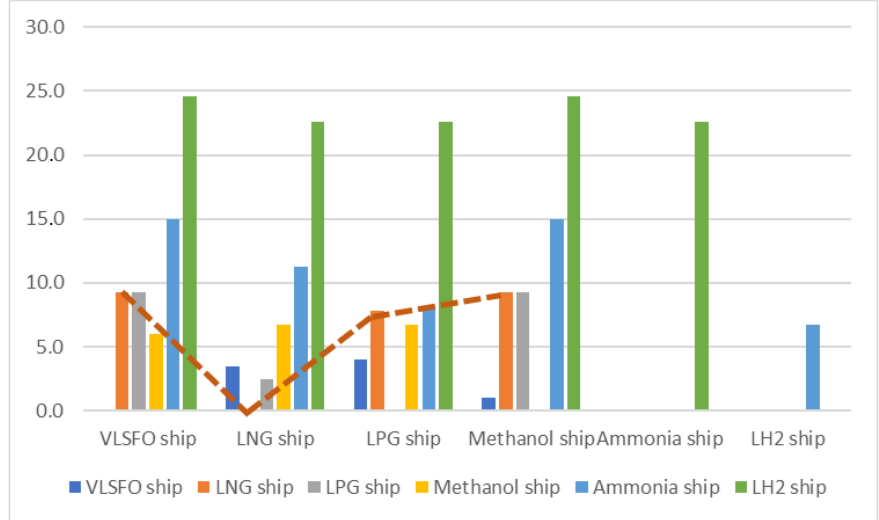
Figure 10. Retrofit cost various types of fuel vessel.